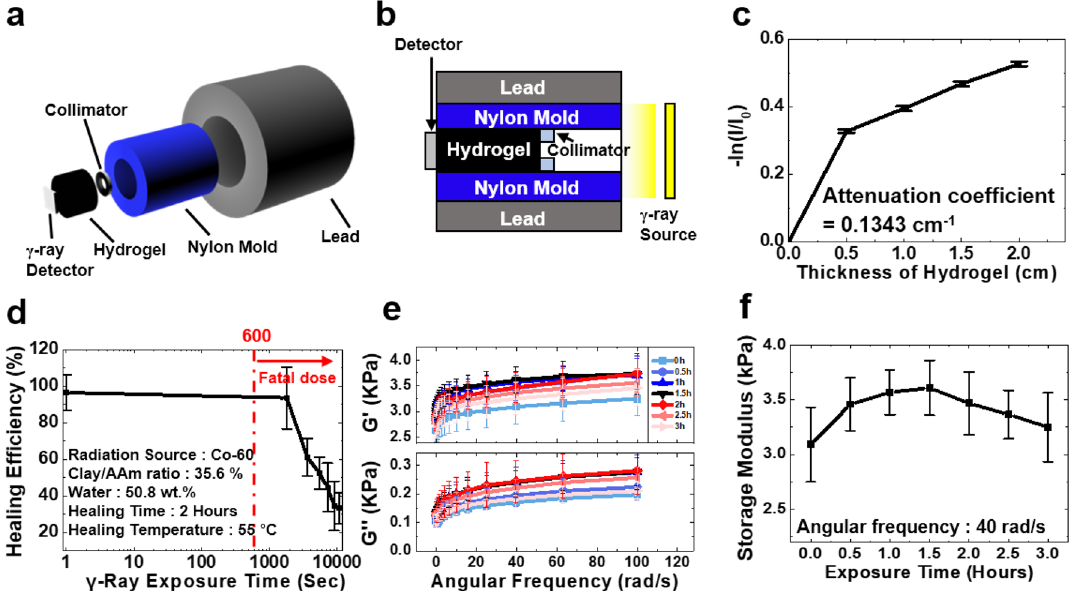
Figure 3. Γ-ray exposure tests on radiation shielding hydrogel composite. ( a , b ) Schematic illustration of experimental apparatus for a measurement of the γ-ray transmission. ( c ) Measurement of logarithmic-scale of transmittance according to thickness of the composites. Attenuation coefficient was calculated using the Beer Lambert Law. Error bars show standard deviation; sample size n = 3. ( d ) Self-healing property of the gel by exposure time. The red dotted line indicates the minimum fatal radiation dose to humans (10 Gy). ( e ) The effect of γ-ray exposure time on PAAm hydrogel expressed as storage and loss modulus graph. The gel does not contain any Laponites and lead dioxides. Error bars show standard deviation; sample size n = 6. ( f ) Storage modulus of PAAm hydrogel at an angular frequency of 40